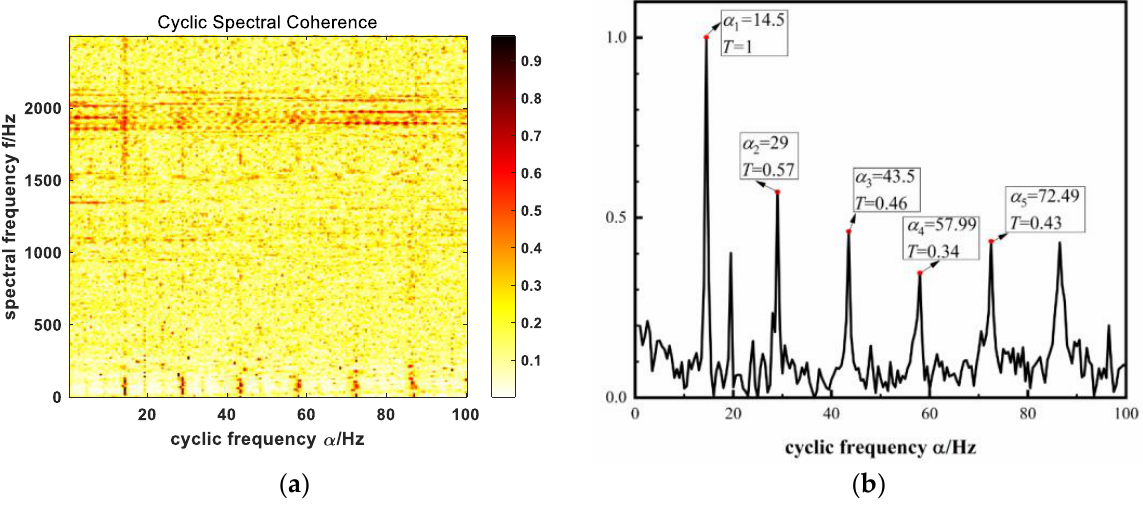
Figure 6. ( a ) The cyclic spectrum coherence function graph of the Robinson R44 helicopter at 0.89 km; ( b ) the cyclic frequency detection results of the Robinson R44 helicopter at 0.89 km.